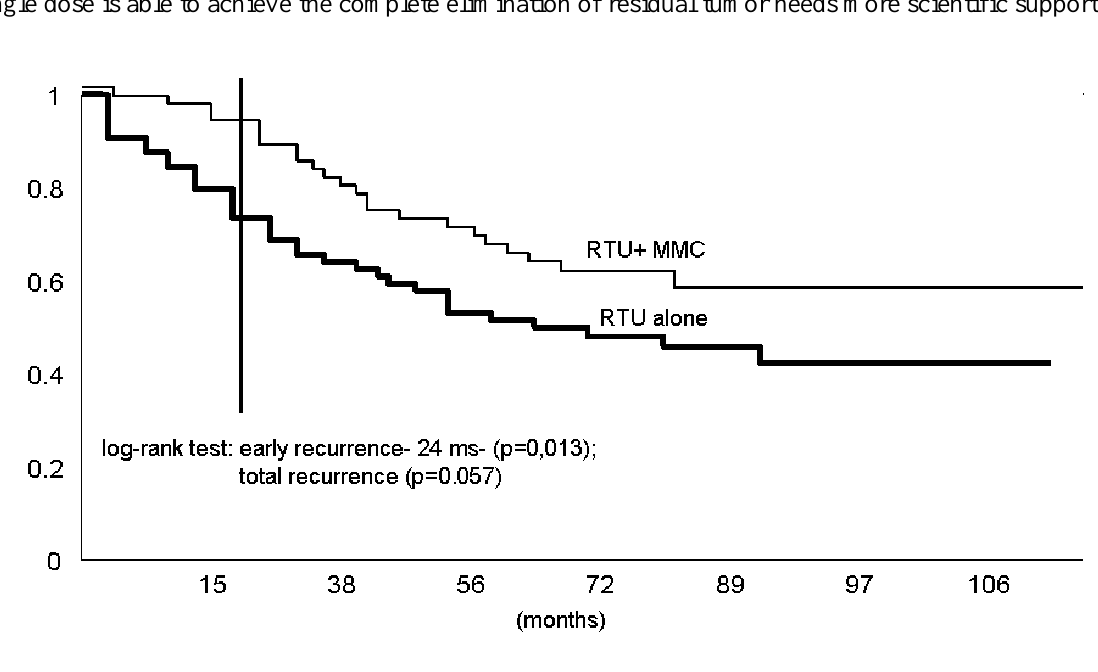
FIGURE 1. Recurrence-free survival comparing a single immediate chemotherapy instillation and observation. Short- and long- term follow-up.